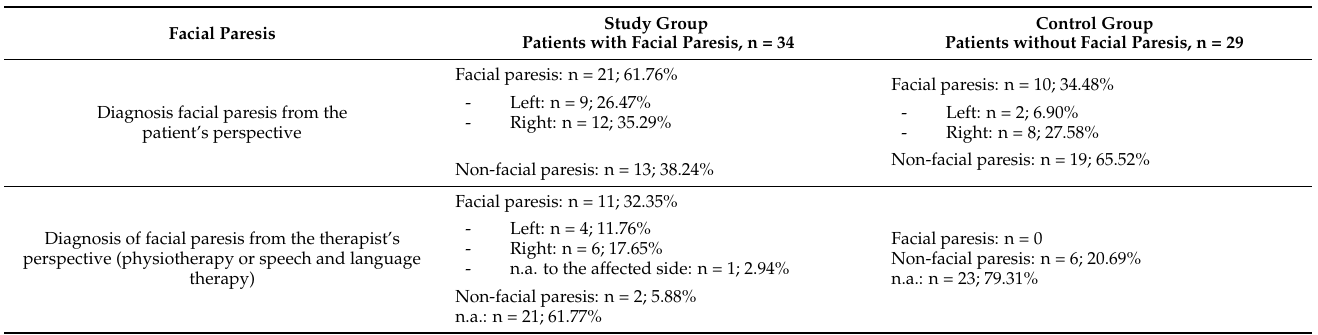
Table A3. Facial paresis information; diagnosis from the patients’ perspectives and from the patients’ therapists’ perspectives, according to the participant; diagnosis via Sunnybrook Facial Grading System [52,53] carried out as part of this study by a logopaedic examiner and severity classification according to the House–Brackmann Facial Nerve Grading System [79], as well as affected side of the face, time post-onset of the examination for this study and already perceived therapy prior to examination in this